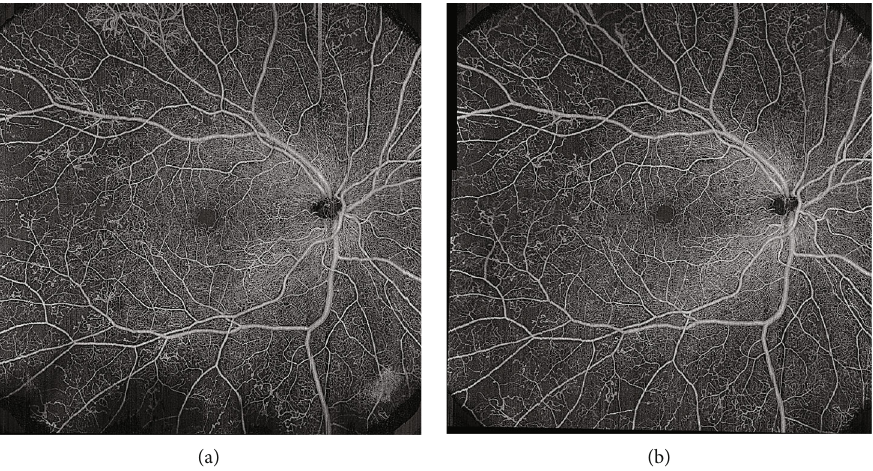
Figure 5: A 12 × 12 mm en face image of the same patient before (a) and after (b) treatment with a combination of panretinal photocoagulation and intravitreal anti-VEGF agents. Complete regression of epiretinal neovascularization is noted. The eyelashes may create masking artifacts (a), which can overestimate the extent of the nonperfusion